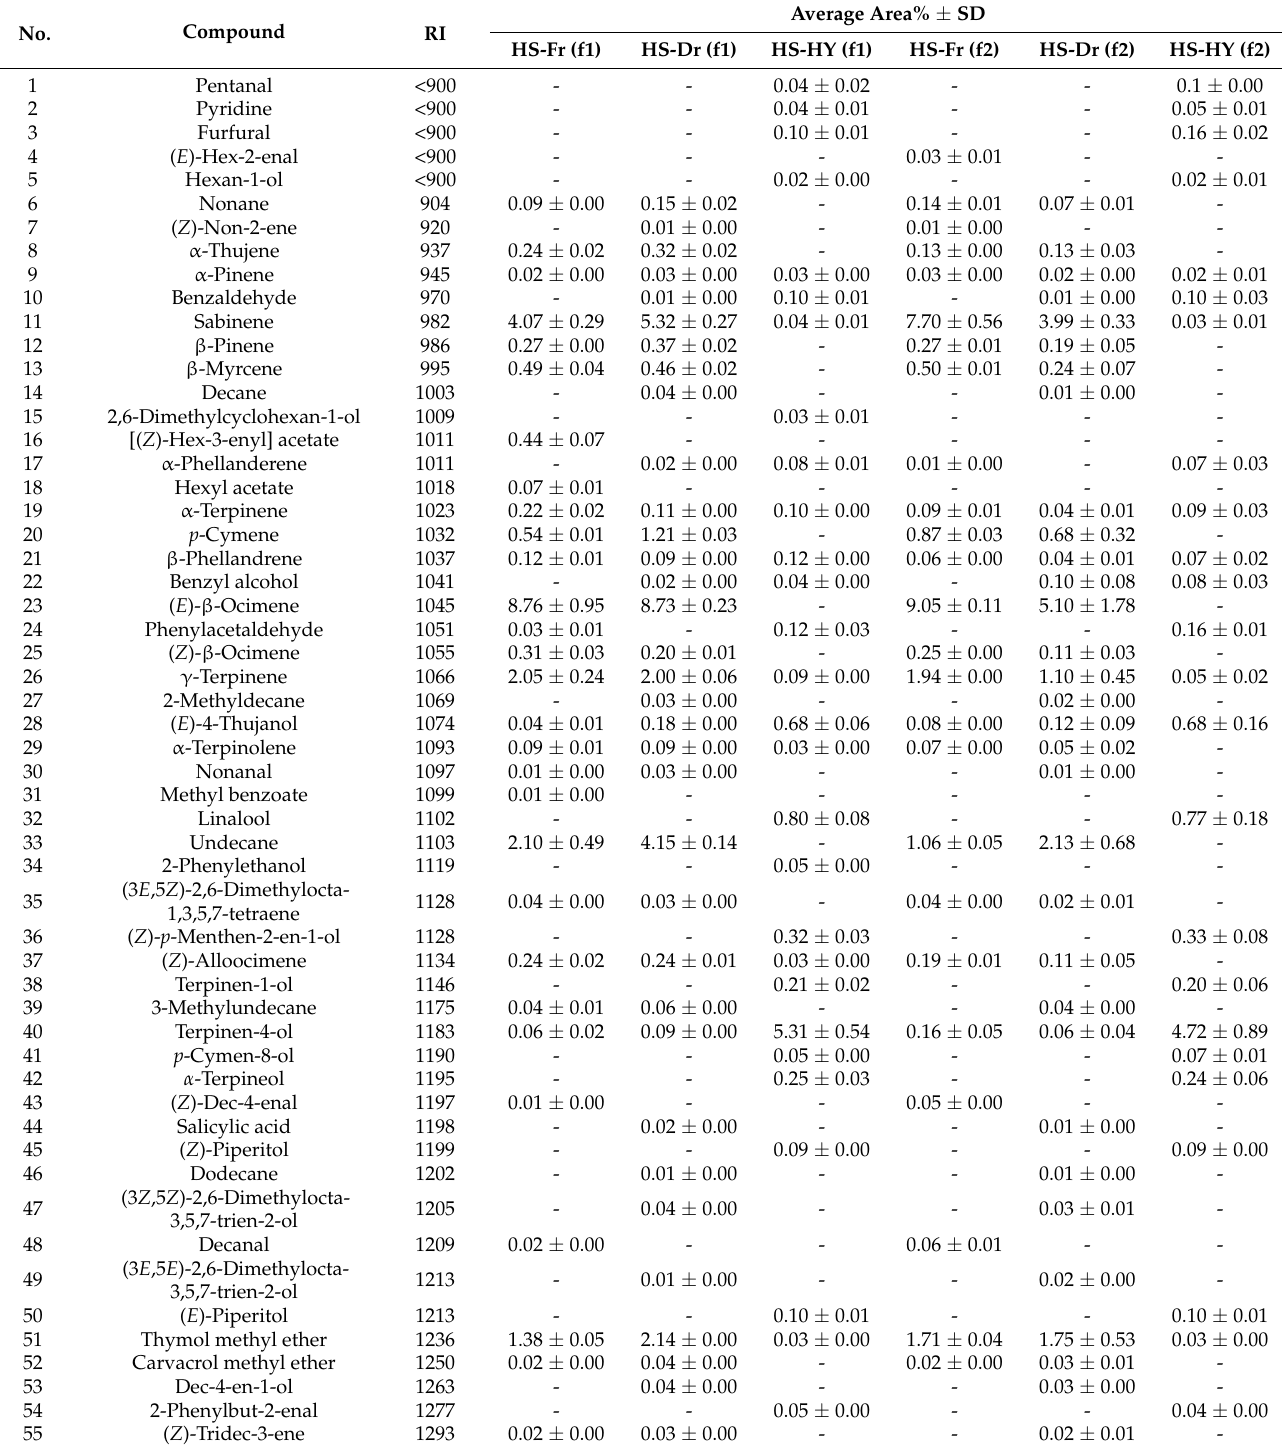
Table 2. Volatile organic compounds isolated by headspace solid-phase microextraction and analyzed by gas chromatography–mass spectrometry from P. ramosissima